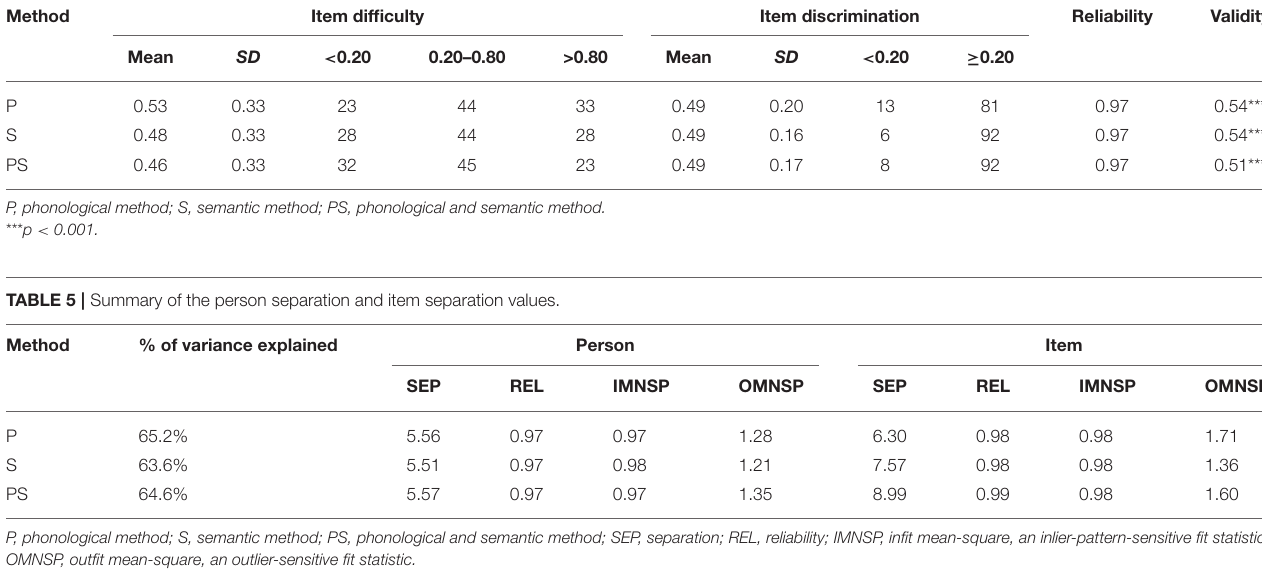
TABLE 4 | Summary of item difficulty and item discrimination of the three measures. Method